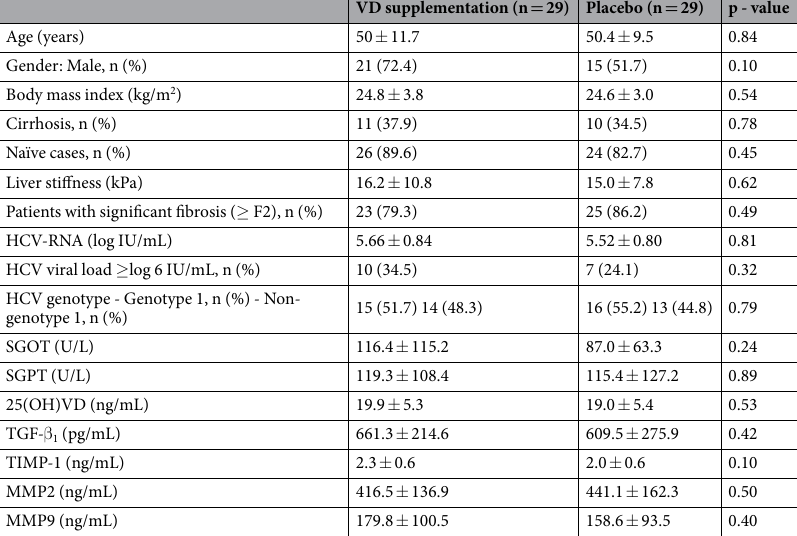
Table 1. Demographic, clinical and laboratory data at baseline in the VD and placebo supplementation groups.